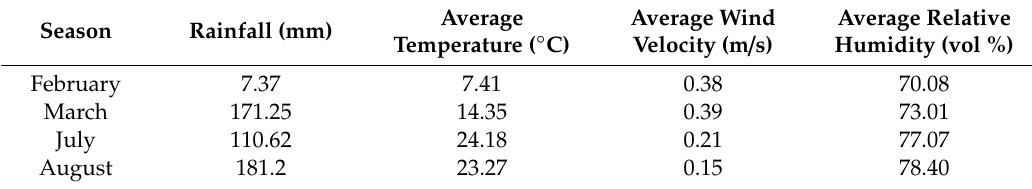
Table 5. Comparison of soil moisture content data in di ff erent mouths based on the